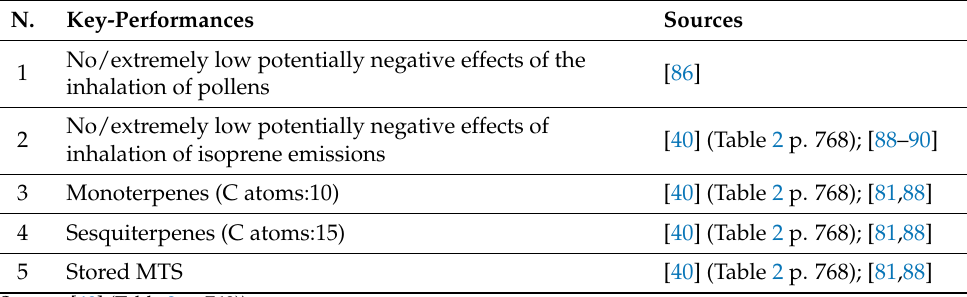
Table 1. HD1 Model: key-performances and sources.